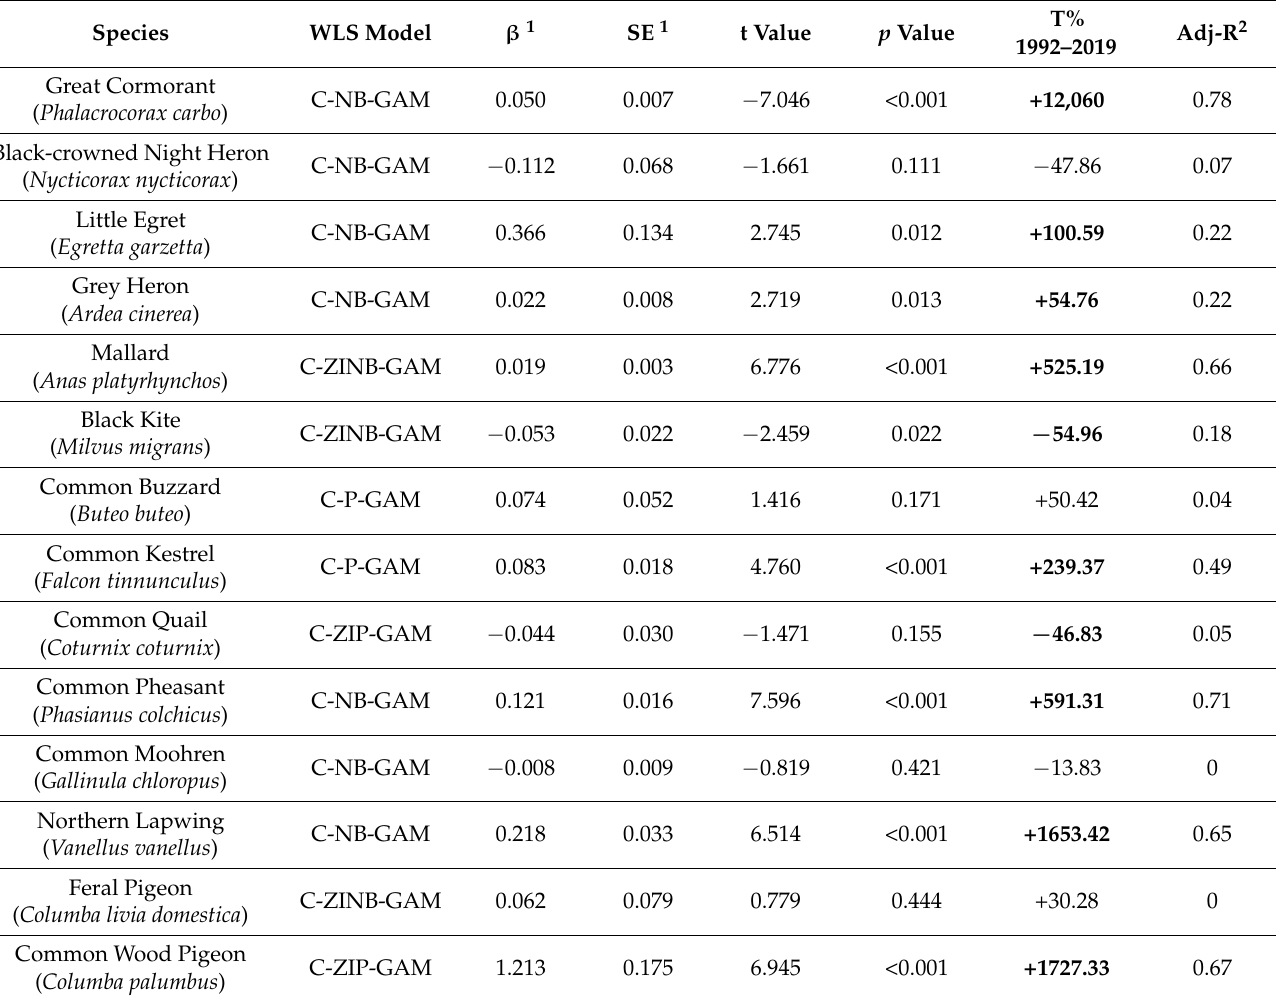
Table 1. Summary of weighted least square linear regression (WLS) for each species. Column “WLS model” indicates the best model selected by AIC, used to perform the linear regression. C, model with covariates dealing with environmental bias; ZIP, zero-inflated Poisson; ZINB, zero-inflated negative binomial; P, Poisson; NB, negative binomial; GAM, generalized additive model. β , estimate of regression coefficient for the explanatory variable “Year”; SE, standard error of β ; t-value, t statistic; T% 1992–2019, percentage of change in the population dimension from 1992 to 2019 according to the WLS model (significant trends are marked in bold); Adj-R 2 : adjusted R-square (in case of negative value it was round to zero). Estimates and standard errors for the intercept are not showed. The common names of the species are presented according to the nomenclature suggested by